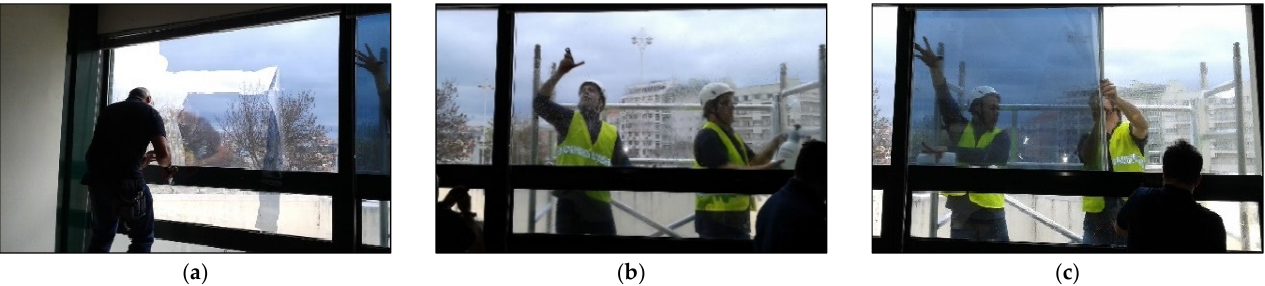
Figure 4. Internal view of the removal of the existent solar control film (SCF) and installation of the new SCF in office I: ( a ) removal of the existing SCF B (internally applied on the glazing); ( b ) cleaning works of the external glass surface of the glazing; ( c ) installation of SCF A on the glazing (external glass surface).